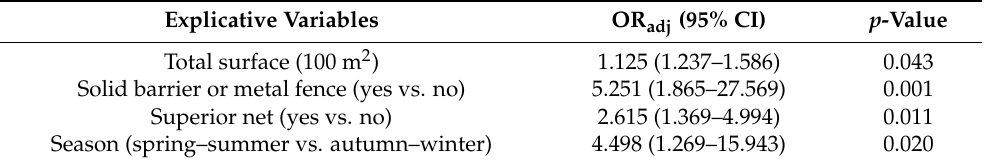
Table 3. Increasing number of insects detected: adjusted Odds Ratios (OR adj ) and 95% Confidence Intervals (95% CI), with associated p -values from the negative binomial regression model fitted using the total number of insects as the outcome. Explicative Variables OR adj (95% CI) Solid barrier or metal fence (yes vs.